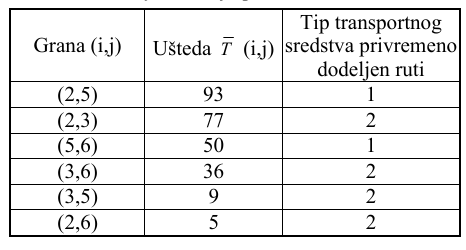
U{tede i tipovi transportnih sredstava nakon